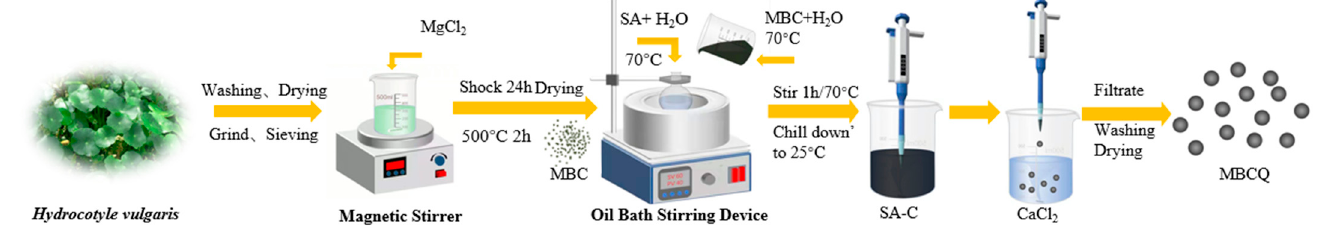
Figure 1. Schematic of the fabrication process of MBCQ.